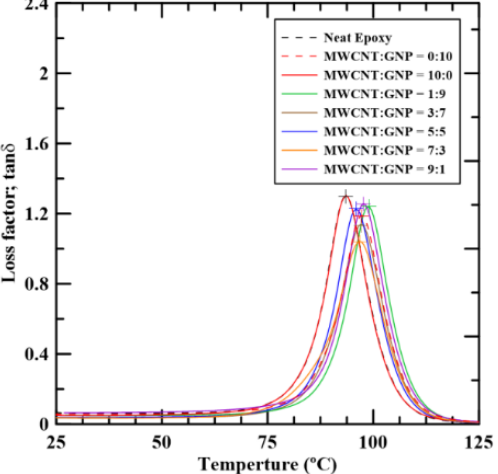
Figure 6. Temperature dependence of the loss factor tan δ of the epoxy composites with various MWCNT:GNP ratios.